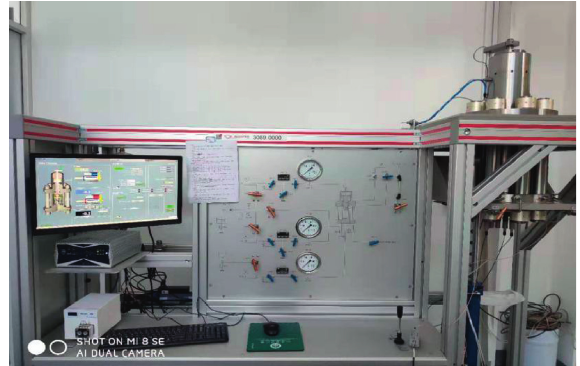
Figure 2: Testing machine of ROCK